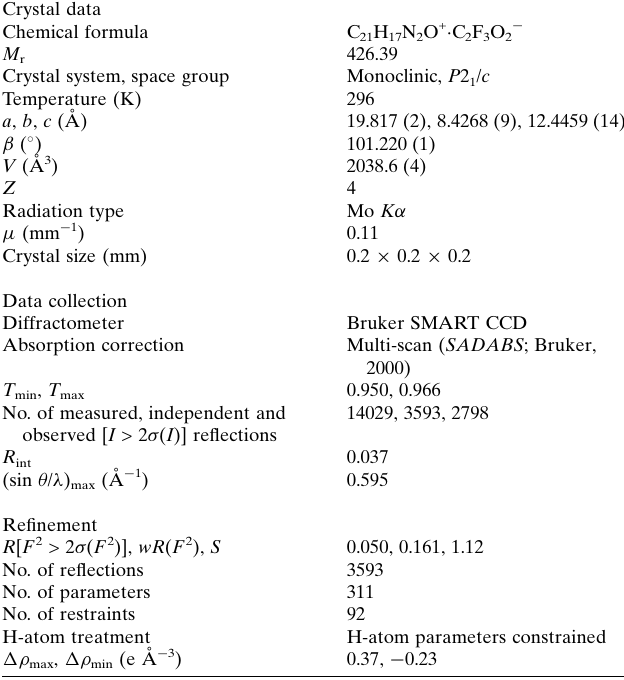
Table 2 Experimental details.